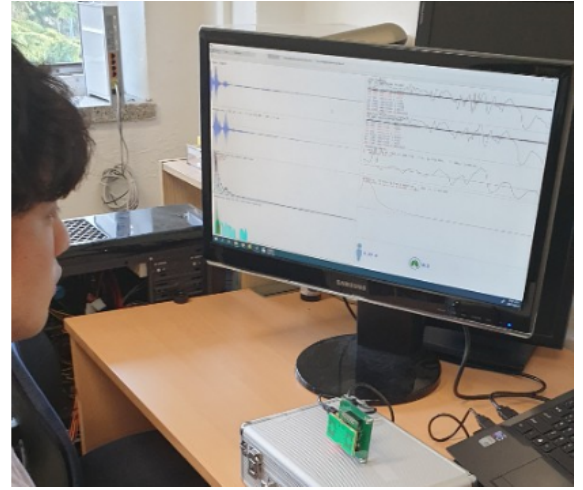
Figure 1. Experiment setup for signal